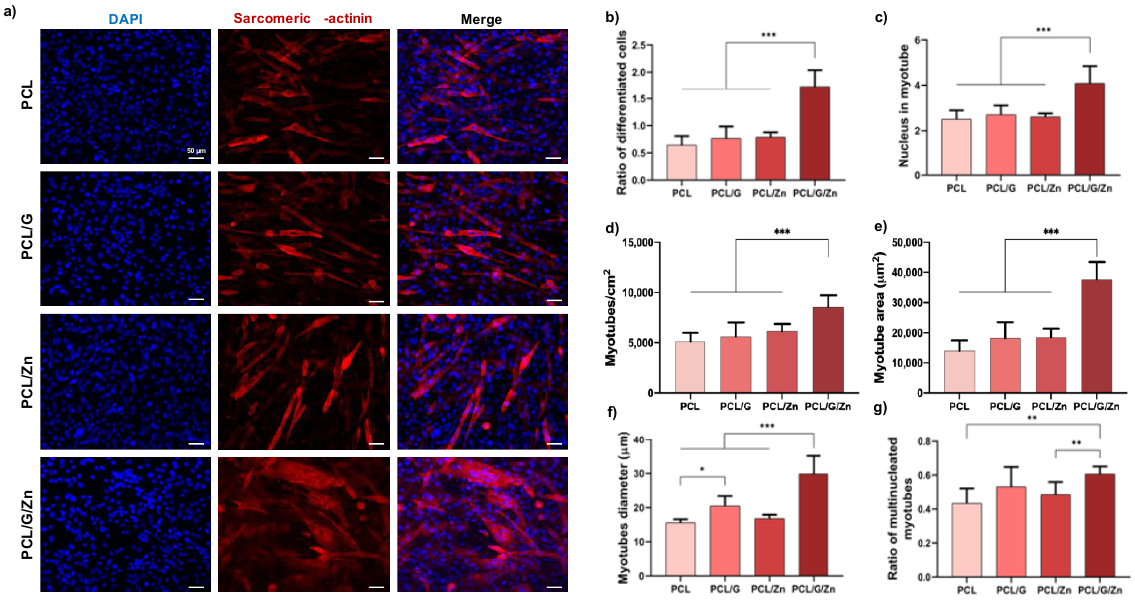
Figure 5. Myoblast differentiation (DMEM +2%FBS +1% P/S culture medium). ( a ) Immunofluores- cence images of differentiated myoblasts (sarcomeric α -actinin staining) after 3 days of culture; ( b ) Ratio of differentiated cells relative to initial cell density; ( c ) Average number of nuclei inside myo- tubes; ( d ) Myotube density; ( e ) Myotube area; ( f ) Myotube diameter analysis of 80 random myo- tubes per condition; ( g ) Ratio of multinucleated myotubes. (*) p < 0.05, (**) p < 0.01, and (***) p < 0.001. Biology 2022 , 11 , x FOR PEER REVIEW Similar results were obtained in C2C12 myoblasts cultured in DMEM supplemented with 1% of insulin-transferrin-selenium (ITS) as differentiation medium (Figure 6). The differentiated cell ratio of conductive substrates supplemented with extracellular Zn 2+ was ca. 140% higher than that of non-conductive PCL, and 69% and 55% higher than PCL/G and PCL/Zn conditions, respectively. In addition, the combination of a conductive surface and exogeneous Zn 2+ ions significantly increased the number of nuclei inside myotubes, number of myotubes/cm 2 , myotube area, myotube diameter, and the ratio of multinucle- ated myotubes over those of all the other conditions.